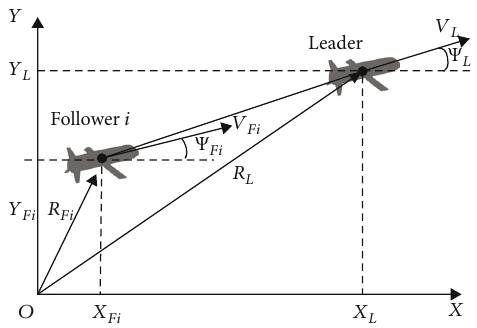
Figure 1: Relative position relationship between leader and follower in the UAV